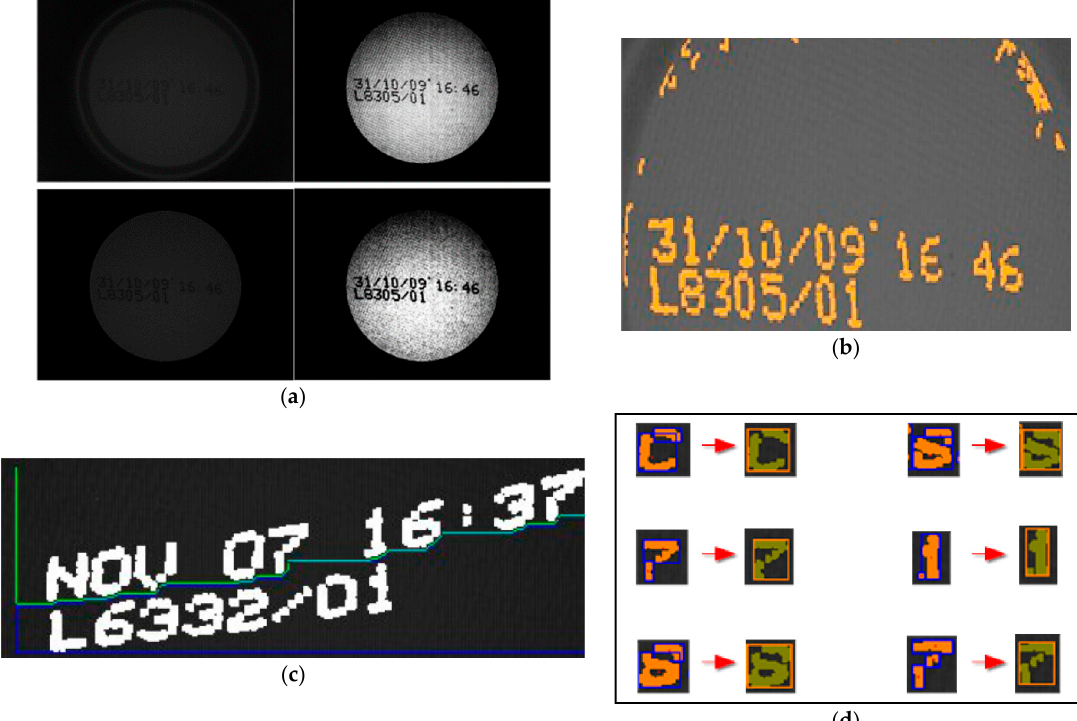
Figure 3. ( a ) Enhancement and equalization of the area of interest. ( b ) Separation of ink and background. ( c ) Organized ink fragments into text lines. ( d ) Grouping the ink fragments into characters.